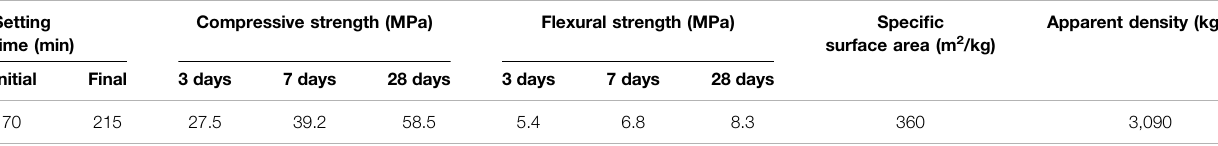
TABLE 1 | Physical and mechanical properties of cement. Setting time (min)